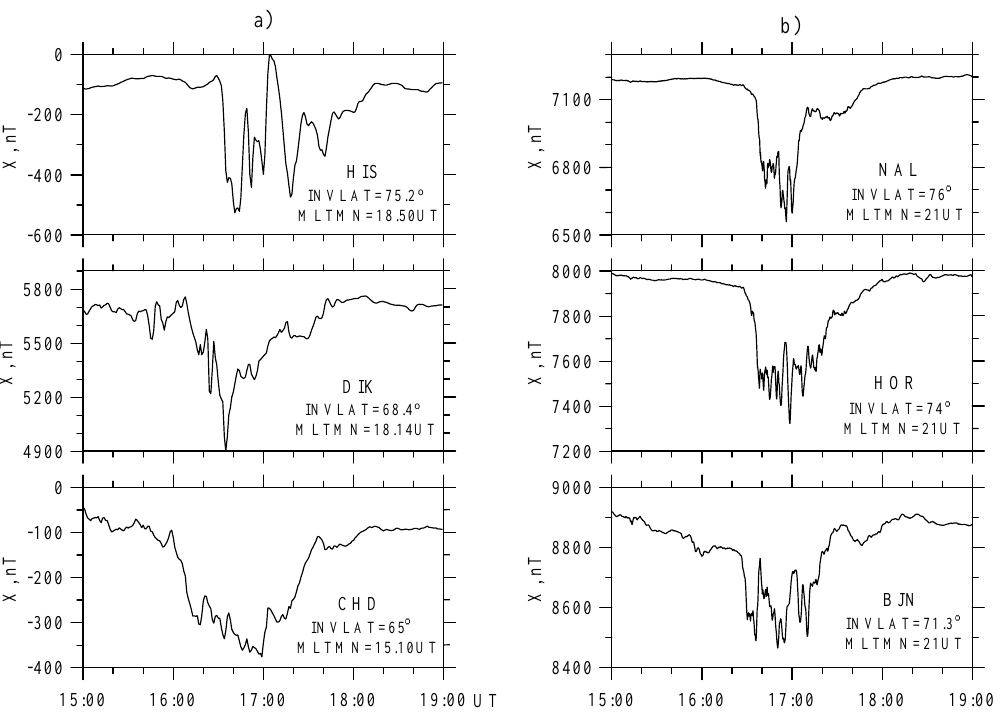
Fig. 1. (a) X -component of the ground magnetic field from Siberia and (b) from Scandinavia for 15:00–19:00UT on 16 December